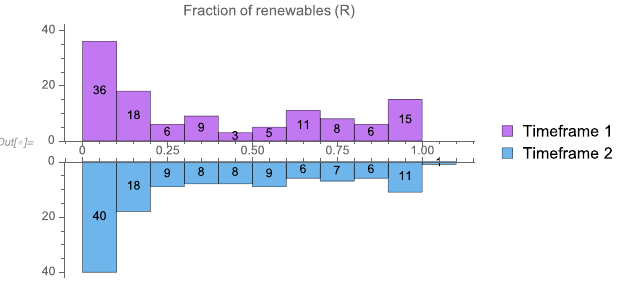
Fig. A.3. Number of countries as a function of R .